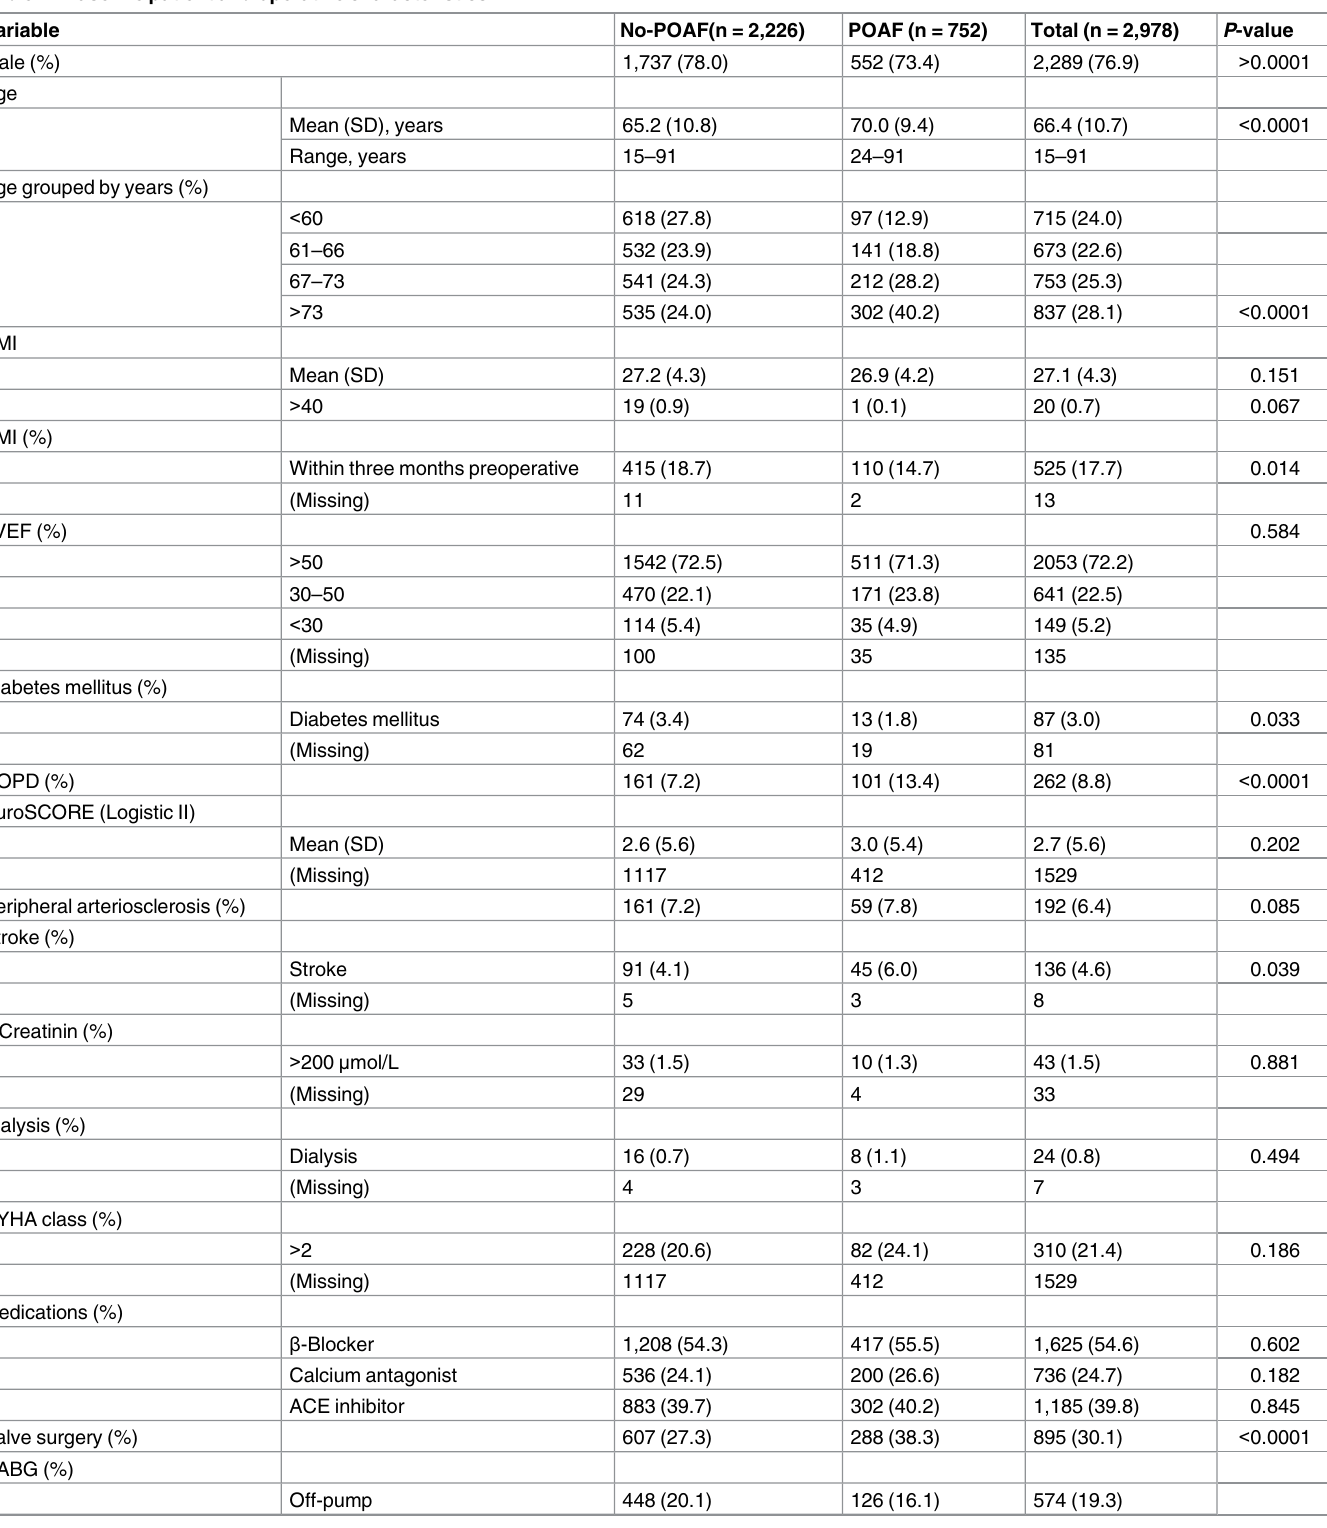
Table 1. Baseline patient and operative